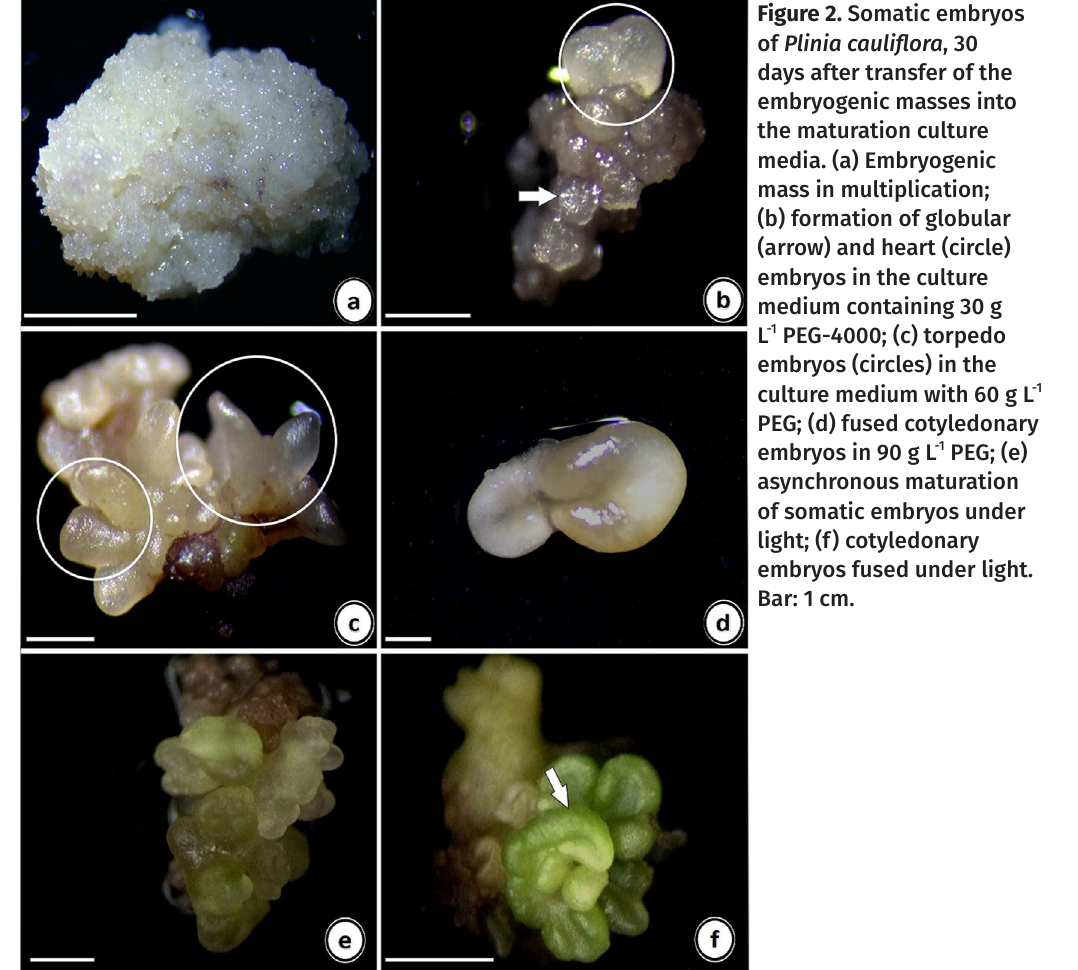
Figure 2. Somatic embryos of Plinia cauliflora , 30 days after transfer of the embryogenic masses into the maturation culture media. (a) Embryogenic mass in multiplication; (b) formation of globular (arrow) and heart (circle) embryos in the culture medium containing 30 g L -1 PEG-4000; (c) torpedo embryos (circles) in the culture medium with 60 g L -1 PEG; (d) fused cotyledonary embryos in 90 g L -1 PEG; (e) asynchronous maturation of somatic embryos under light; (f) cotyledonary embryos fused under light. Bar: 1